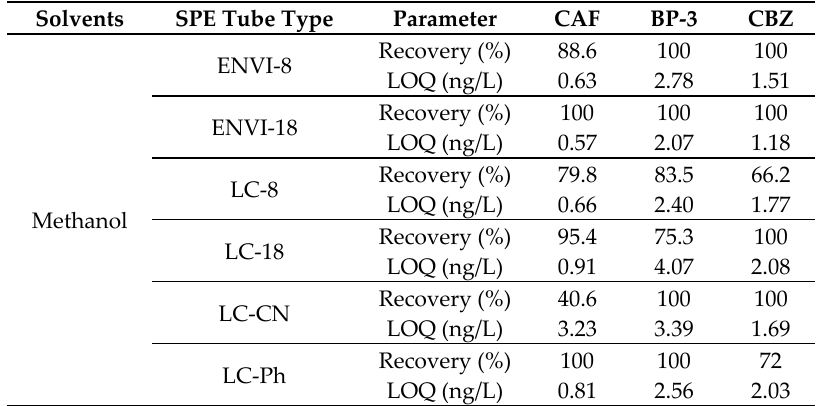
Table 5. Recovery and LOQ for various combinations of SPE Tube types and the solvents.